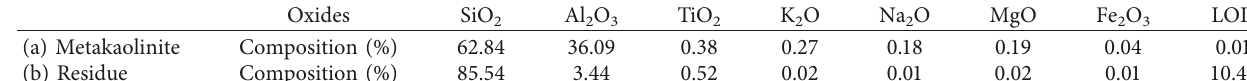
Figure 4: The kinetic model of aluminum extraction from kaolinite controlled by surface chemical reaction and the photos of kaolinite and extracted aluminum chloride hexahydrate crystals from leaching at 0.10g · mL − 1 , 5M, 80 ° C, and 180min. Table 5: Chemical compositions of Ethiopian metakaolinite at 700 ° C for 180min and residue.